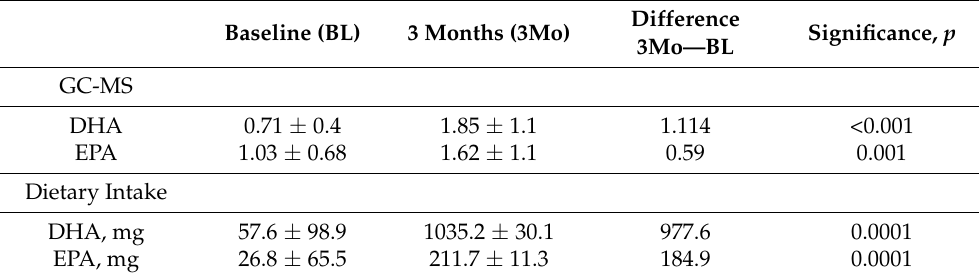
Table 2. En Balance-Plus participants reported dietary and GC-MS relative omega-3 PUFAs levels at baseline and three months ( n =